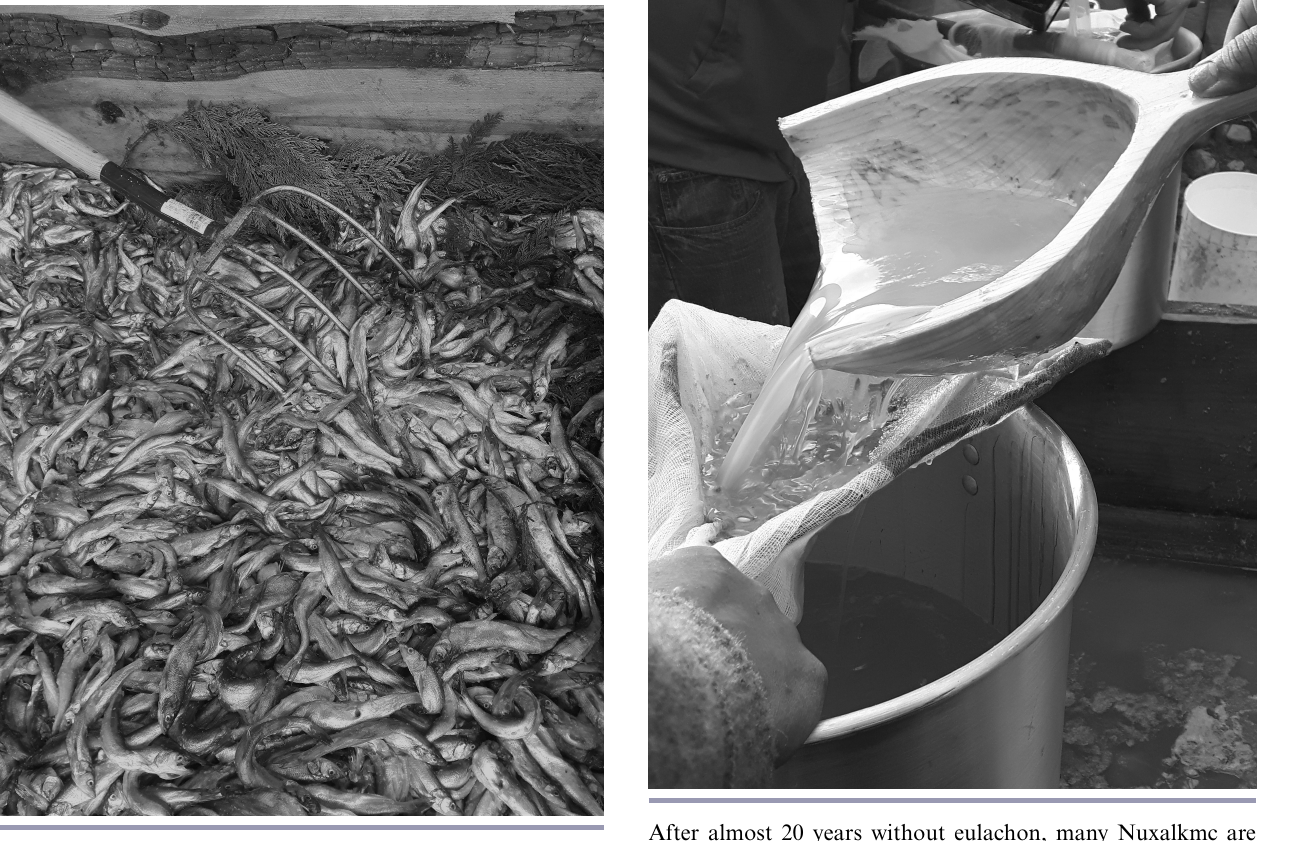
Fig. 2 . Eulachon ( Thaleichthys pacificus ) from the Nass River fermenting in a stink box in preparation for making sluq (eulachon grease).